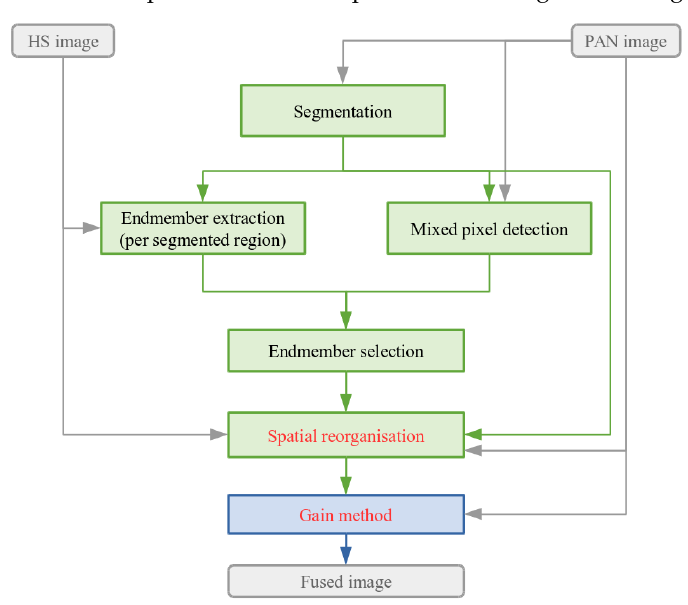
Figure 2. Flow chart of the CONDOR method [44]. The preprocessing steps are framed in green, with the fusion step in blue; the improved CONDOR-2P steps are identified in